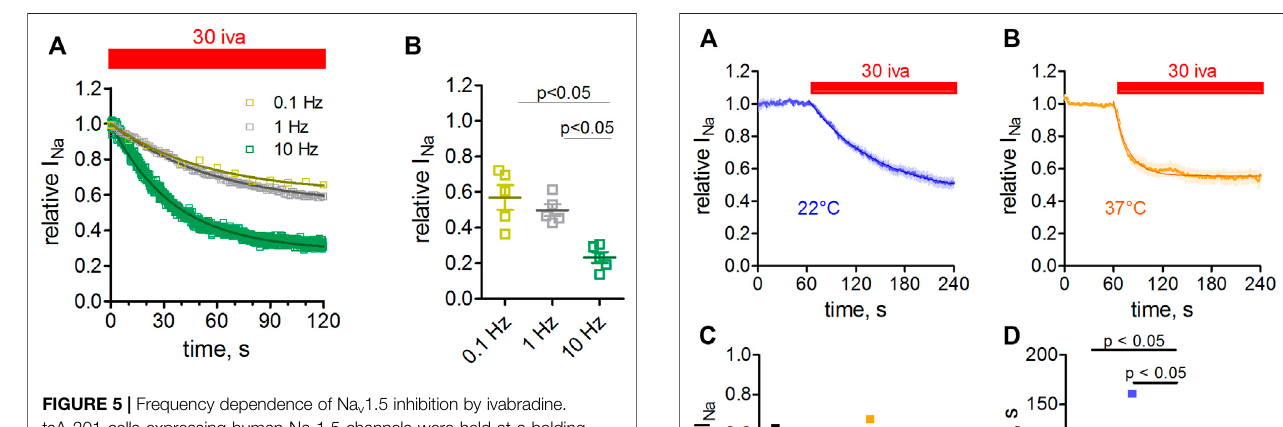
FIGURE 5 | Frequency dependence of Na v 1.5 inhibition by ivabradine. tsA-201 cells expressing human Na v 1.5 channels were held at a holding potential of − 100 mV and depolarized to -10 mV for 25 ms at a frequency of either 0.1, 1, or 10 Hz. (A) Maximal peak inward sodium current amplitude during − 10 mV depolarizations was monitored over time. After stable amplitude had been established 30 µM of ivabradine was washed in. Current amplitude values in the continuous presence of 30 µM ivabradine were normalized to respective control values before drug application (norm Na v 1.5 current). The level of inhibition was signi fi cantly lower at 10 Hz comparedto0.1and1 Hzpulsefrequency. (B) Summaryofinhibitionlevelsas derived from single-exponential fi ts to the data shown in A ; mean ± SEM from n = 5, 5, and 5 independent experiments for 0.1, 1, and 10 Hz, respectively.